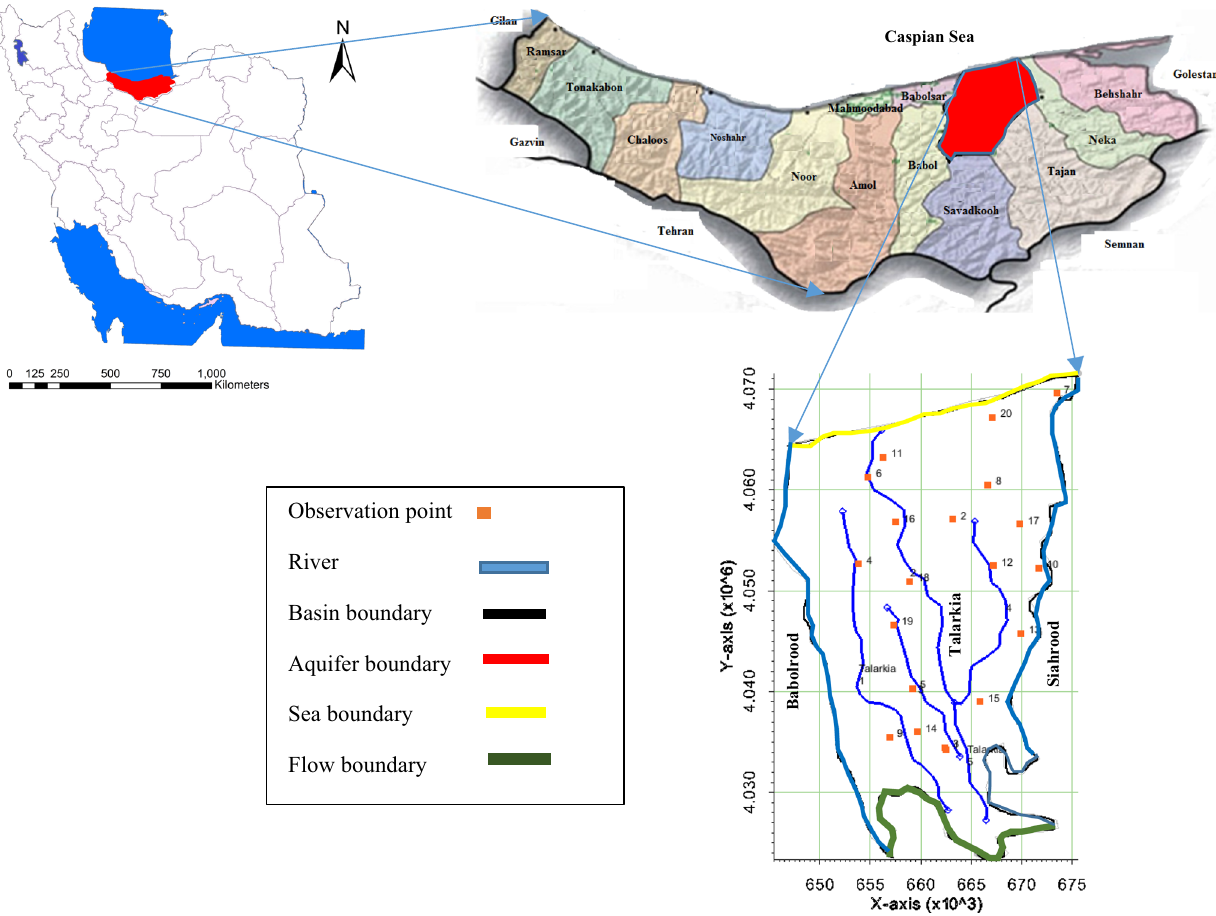
Fig. 1 Boundary conditions and monitoring points of Talar